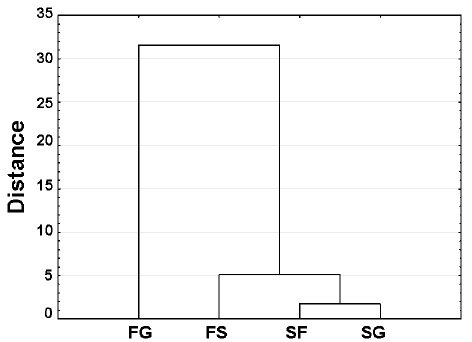
Figure 1. Dendrograms presenting multivariate similarity of the fe- male turkey genotypes (SG – slow growing; FG – commercial fast growing; reciprocal crossbreed: SF (SG sires × FG dams); FS (FG sires × SG dams)), according to the examined blood parameters: creatinine, bilirubin, albumins, total protein, heterophils, lympho- cytes and heterophil / lymphocyte ratio based on cluster analysis (Ward’s method of agglomeration).